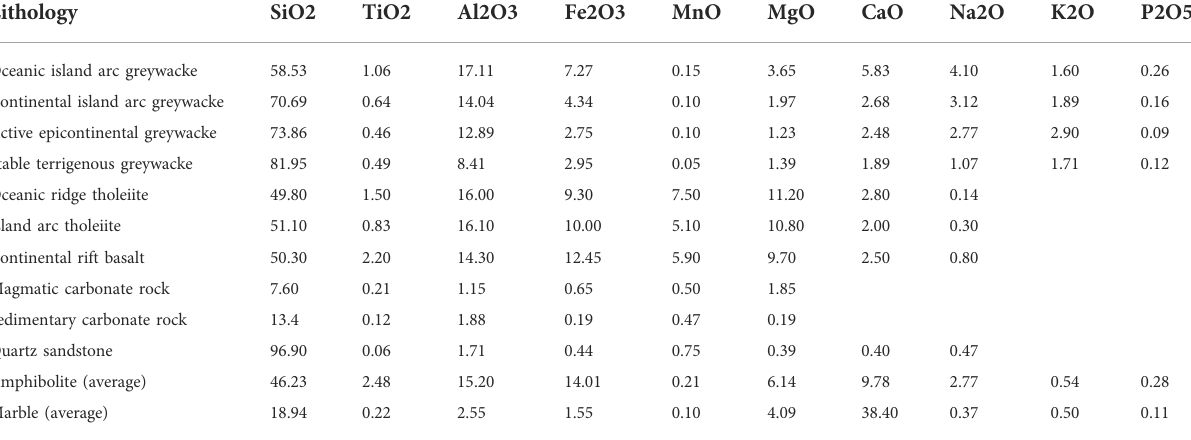
TABLE3SomeelementcontentsofmetamorphicrocksfromtheXunyangbaareaandotherrocksinliteraturestudies(thedataarefromWang(1987),; Liu (1988),; and Li et al. (2006)).